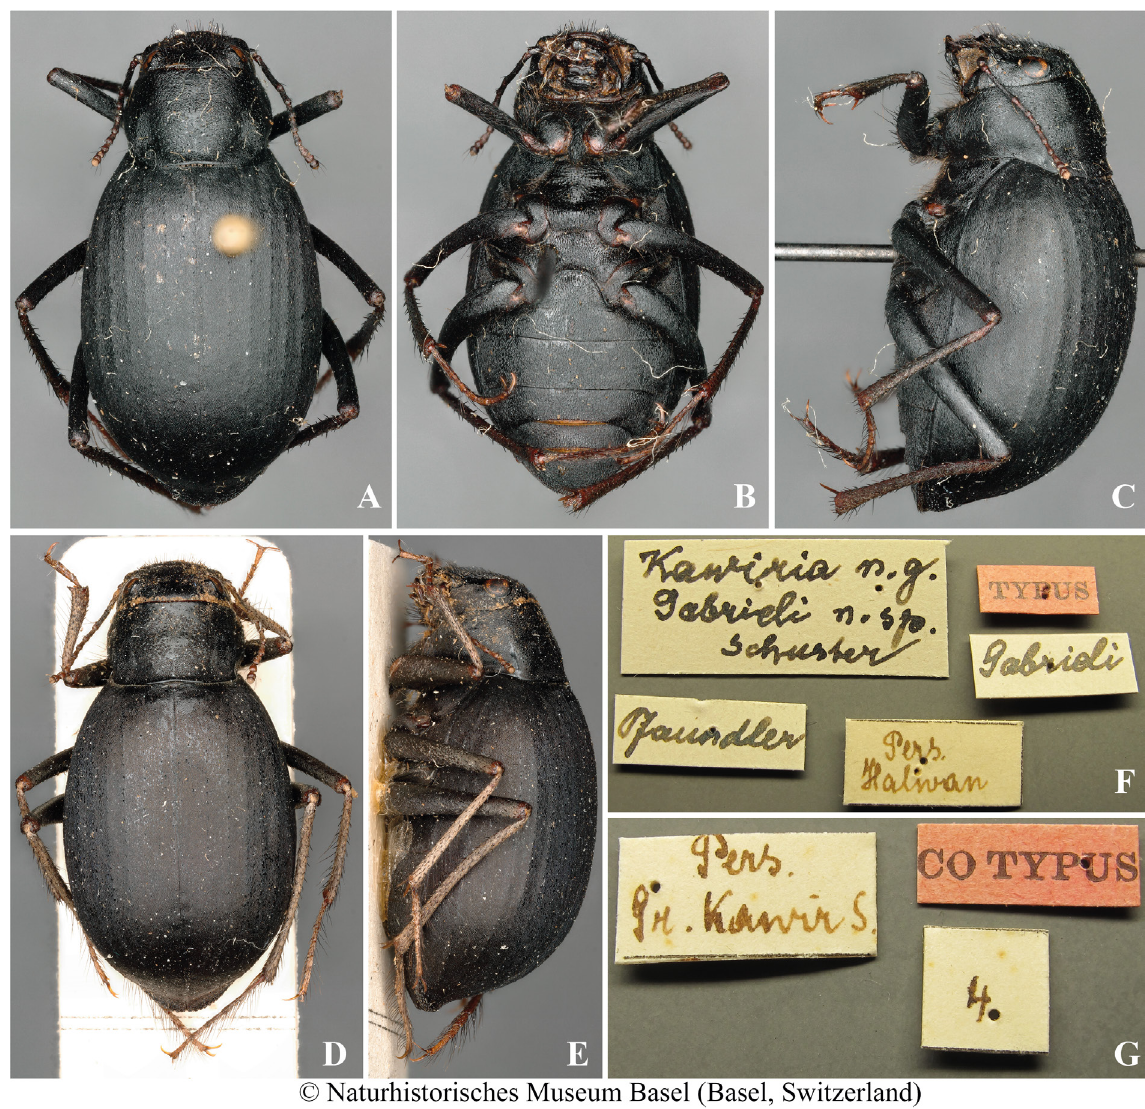
Fig. 2. Habrobates gabrieli (Schuster, 1935) comb. nov., type specimens, habitus, labels (NHB). A . Lectotype, dorsal view. B . Ditto, ventral view. C. Ditto, lateral view. D . Paralectotype, dorsal view. E . Ditto, lateral view. F . Labels of the lectotype. G . Labels of the paralectotype. Photos courtesy